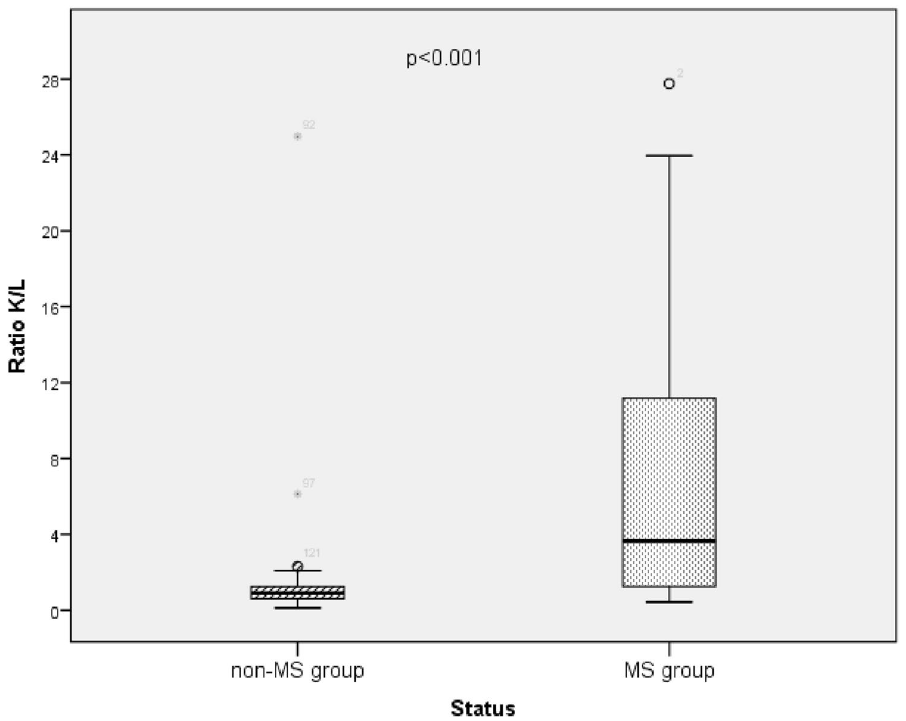
Figure 1. Box plots illustrating the comparative distribution of CSF κ/λ ratio in multiple sclerosis (MS) and non-MS group (U test of Mann–Whitney). Horizontal solid lines indicate medians.